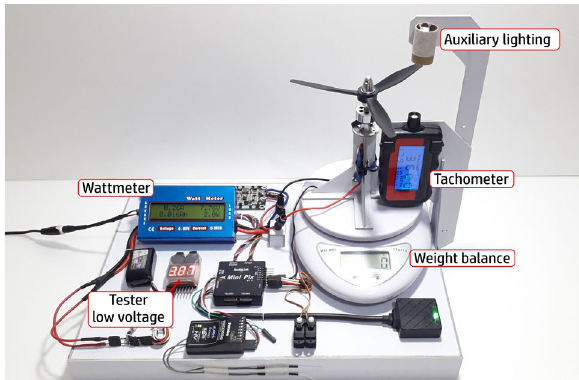
Figure 29. Bench test platform for determining propellers parameters.